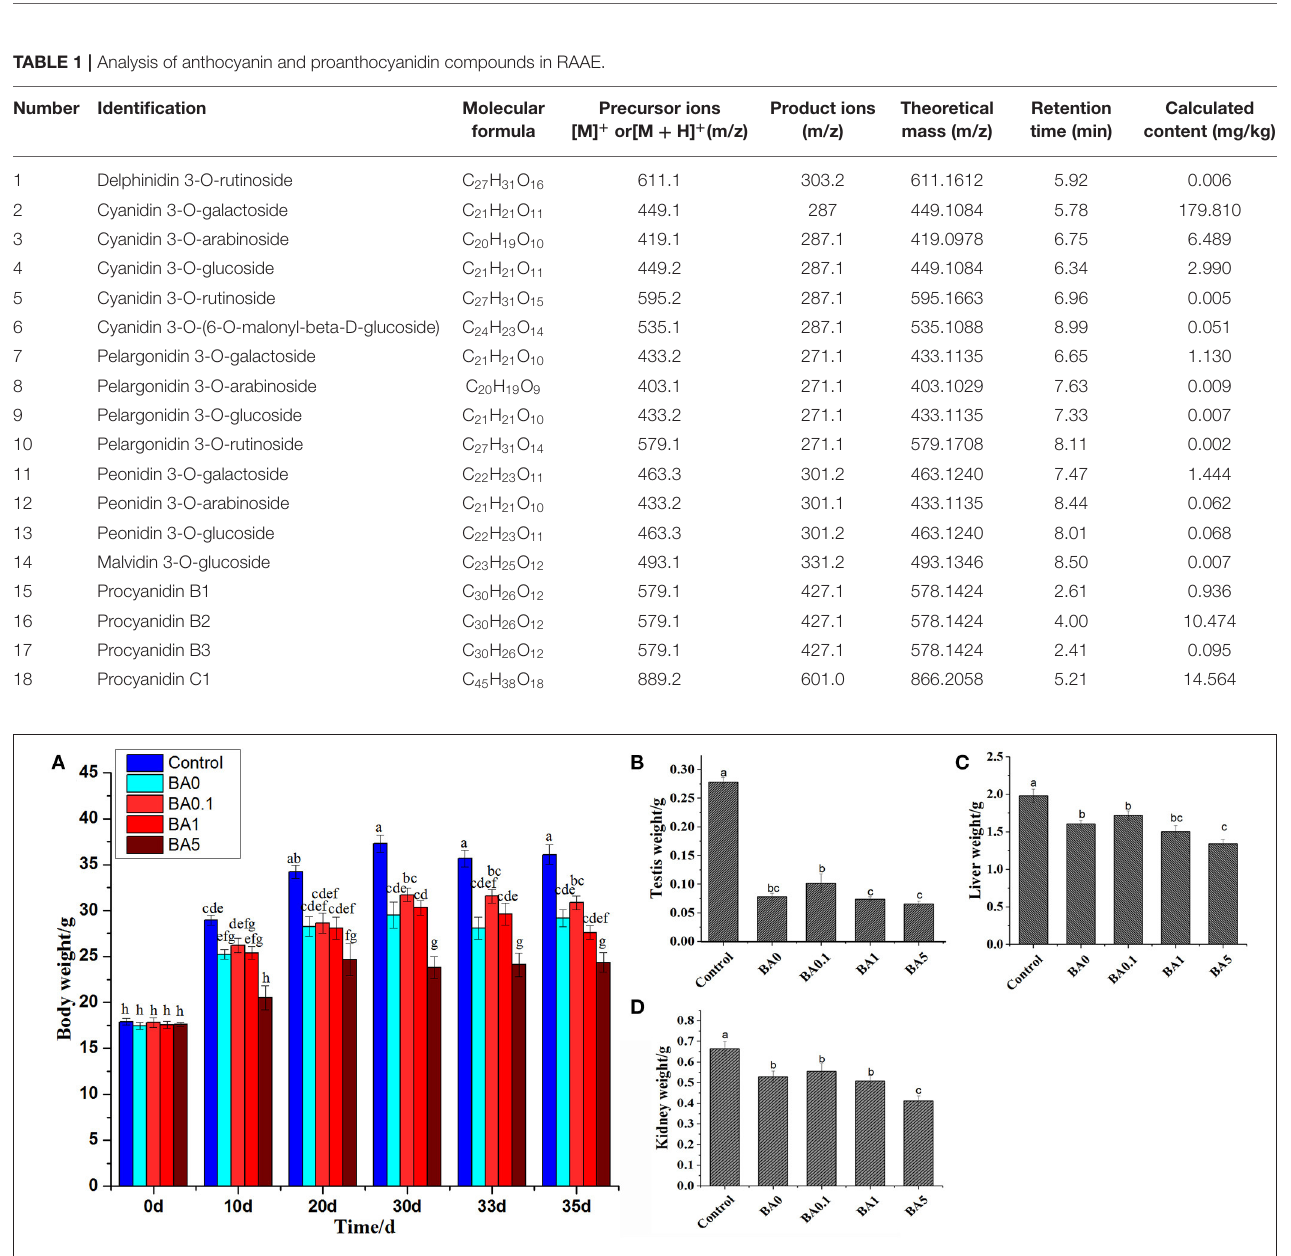
was significantly lower than that of the control group